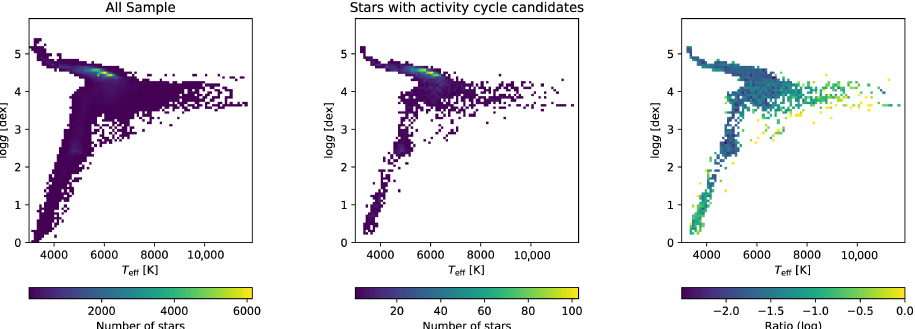
Figure 14. The left panel is the T eff vs. log g diagram of all Kepler targets. The middle panel is the same diagram of 4455 stars with activity cycle candidates found by this work. The right panel is the ratio of the middle and the left.